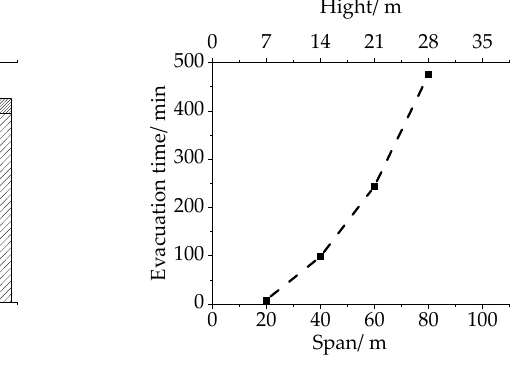
( b ) Evacuation times of structures with different spans.